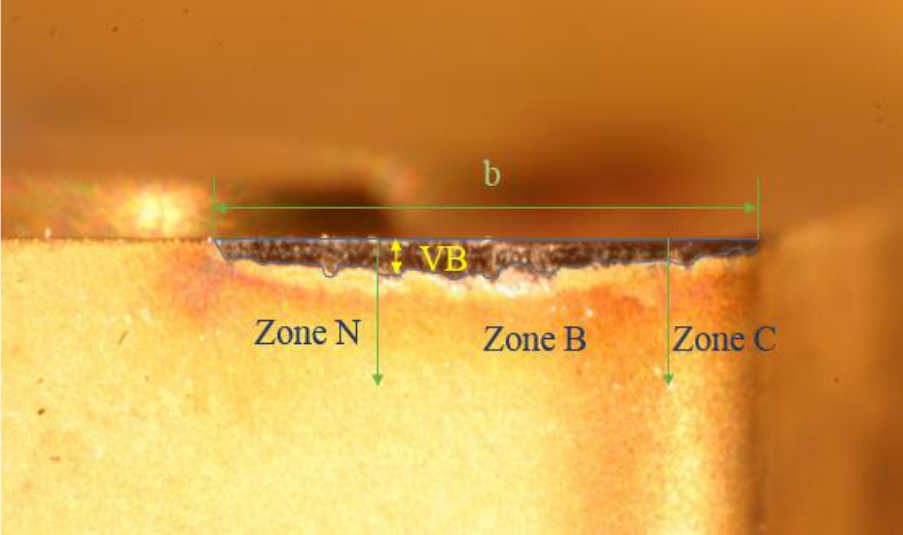
Figure 3. A typical tool wear, V B max, and different wear zones [26].